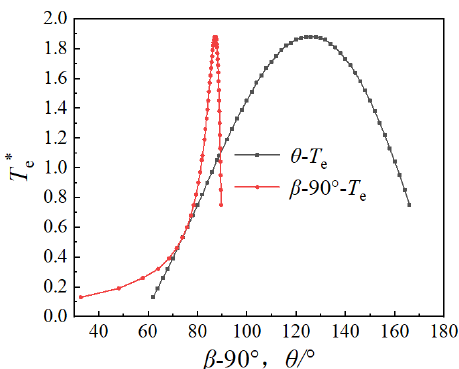
Figure 14. The curve of per unit value of torque at λ = 0.5.